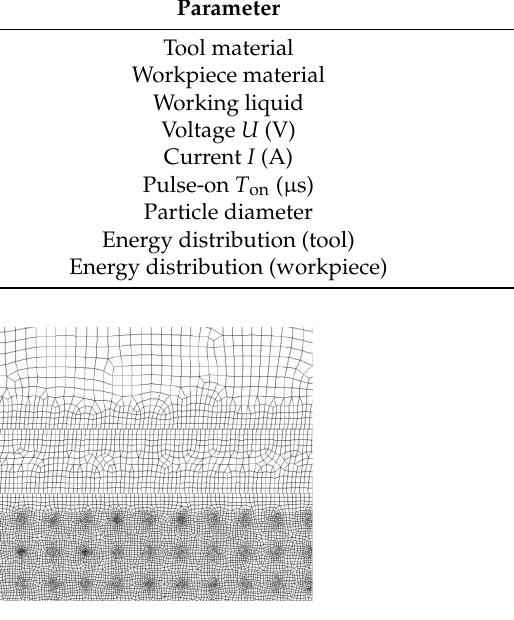
Figure 4. The meshed model. Table 1. Simulation parameters in the melting simulation.